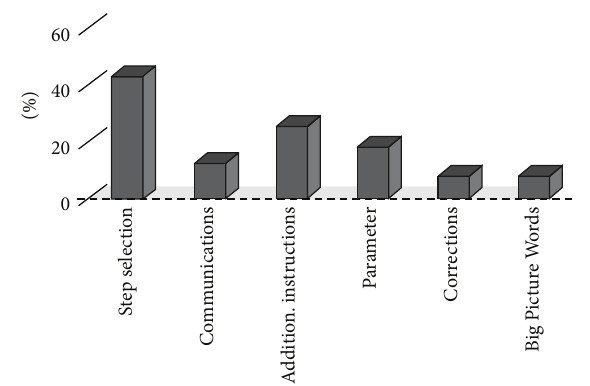
Figure 4: Use of Execution Notes ( 𝑁 = 160